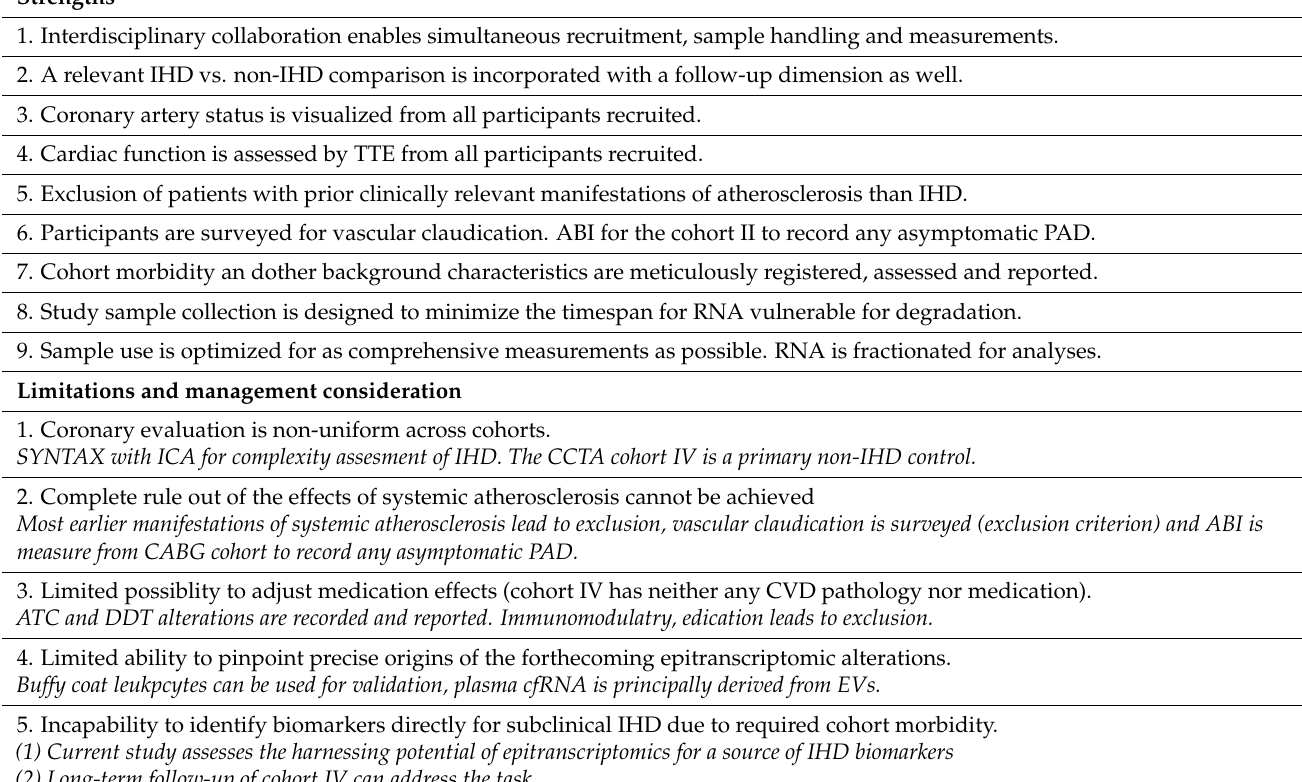
Table 5. Consideration of the strengths and limitations of the IHD-EPITRAN study. ABI , ankle-brachial index, ATR , anatomical therapeutic chemical classification system; AVR , aortic valve replacement cohort III; AVS , aortic valve stenosis; CABG , coronary artery bypass grafting cohort II; CCTA , coronary computed tomography angiogram cohort IV; CVD , cardiovascular disease; DDT , defined daily dose, EV , extracellular vesicle; ICA , invasive coronary angiography; IHD , ischemic heart disease; PAD , peripheral artery disease; TTE , transthoracic echocardiography.